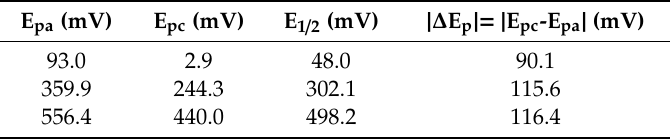
Figure 3. Quasi-reversible redox processes of stannole 4 at 298 K. The conducting salt was 0.1 M Bu 4 NPF 6 in dichloromethane and the scan rate was 0.2 V / s. The spectrum is referenced against F / Fc + . Table 1. Values of E pa , E pc , E 1 / 2 and | ∆ E p | against F / Fc + .